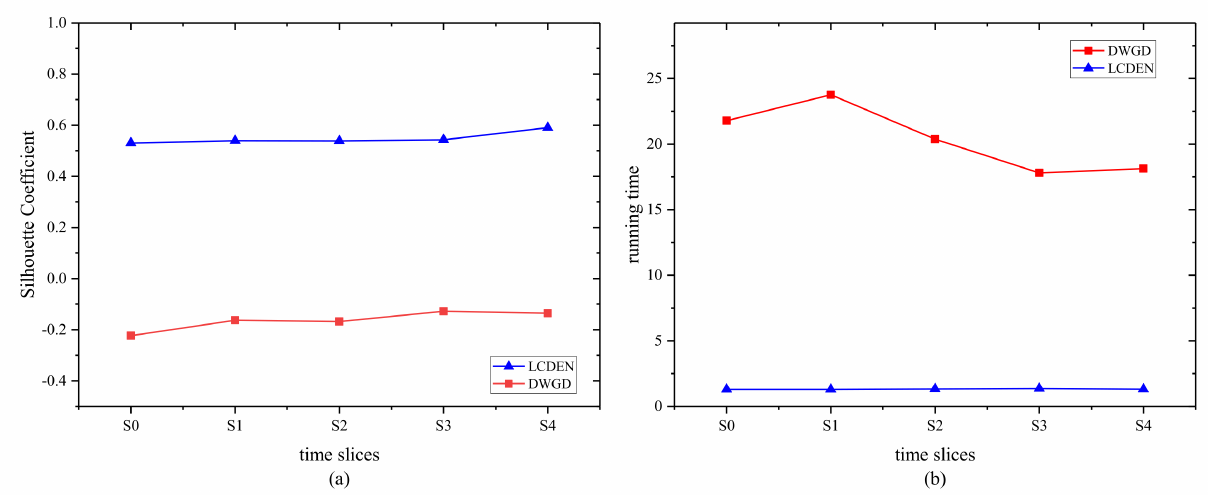
Figure 1. Comparison of the Silhouette Coefficient ( a ) and running time ( b ) on the Superuser temporal network.